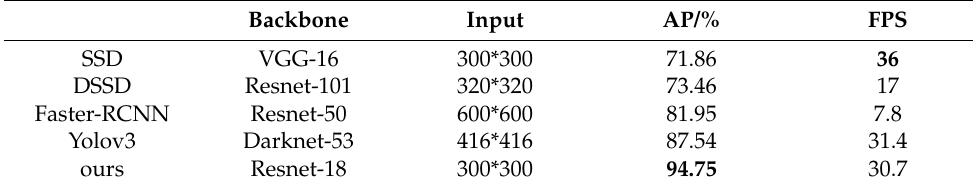
Table 1. Comparison of test